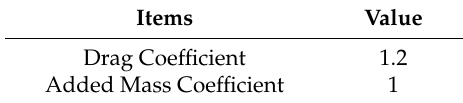
Table 4. Environmental parameters for the hydrodynamic basin test.